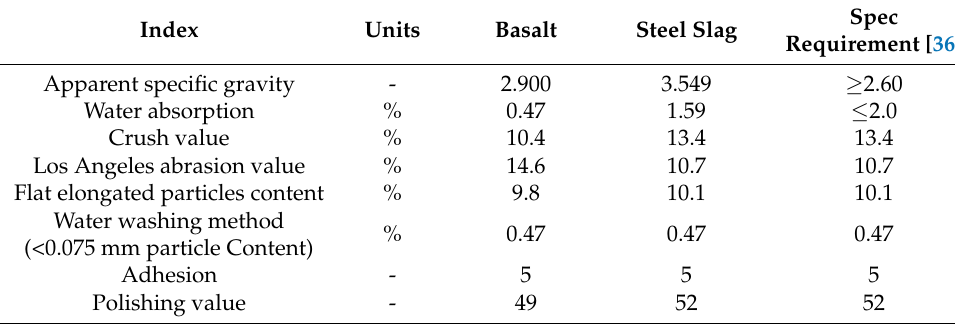
Table 2. Technical Indices of the Basalt and Steel Slag Coarse Aggregates.